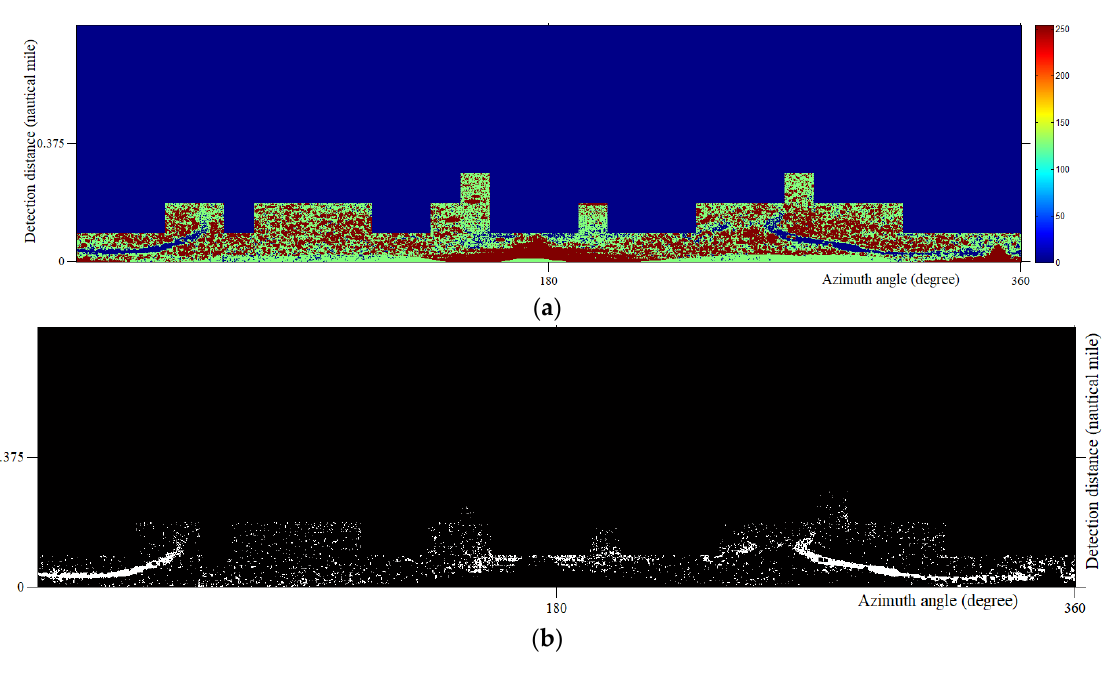
Figure 9. Rough oil films segmentation result. ( a ) FCM classification; ( b ) Rough segmentation result.